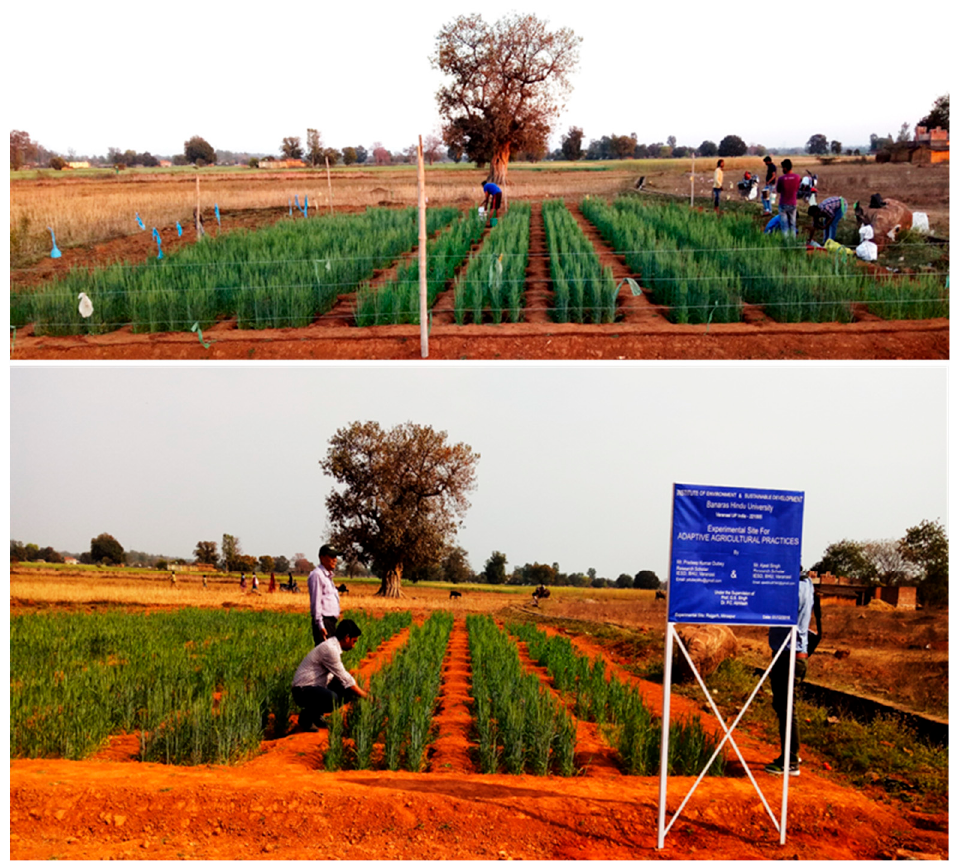
Figure 5. Field gene bank for conservation of neglected and underutilized crops. Maintaining germplasms of promising species at farmer’s field itself is a promising strategy for conservation. Figures shows the cultivation of wheat in the farmer’s field of Rajgarh, Mirzapur district, UP, India.